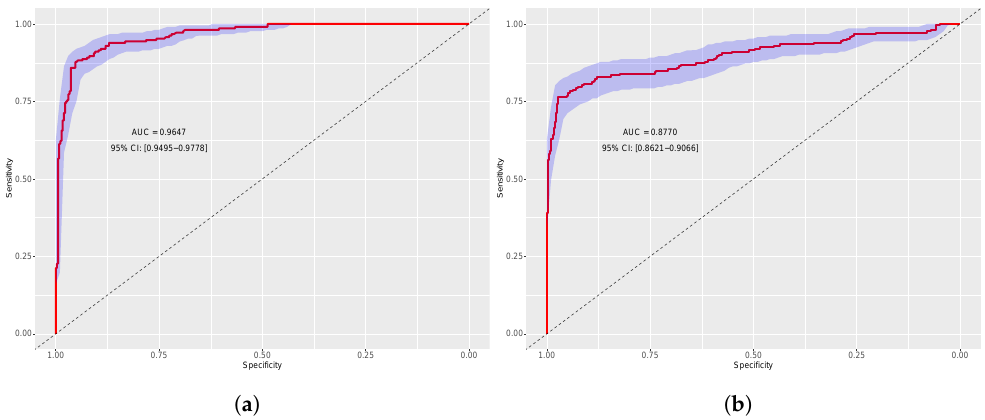
Figure 3. ROC curves obtained by the EFC-ID and FKM approaches. ( a ) ROC curve obtained by EFC-ID approach; ( b ) ROC curve obtained by FKM approach.